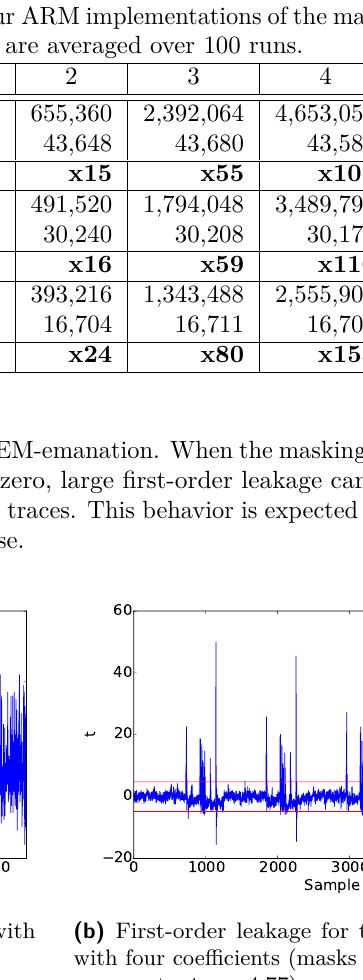
Figure 2: Sample trace and reference